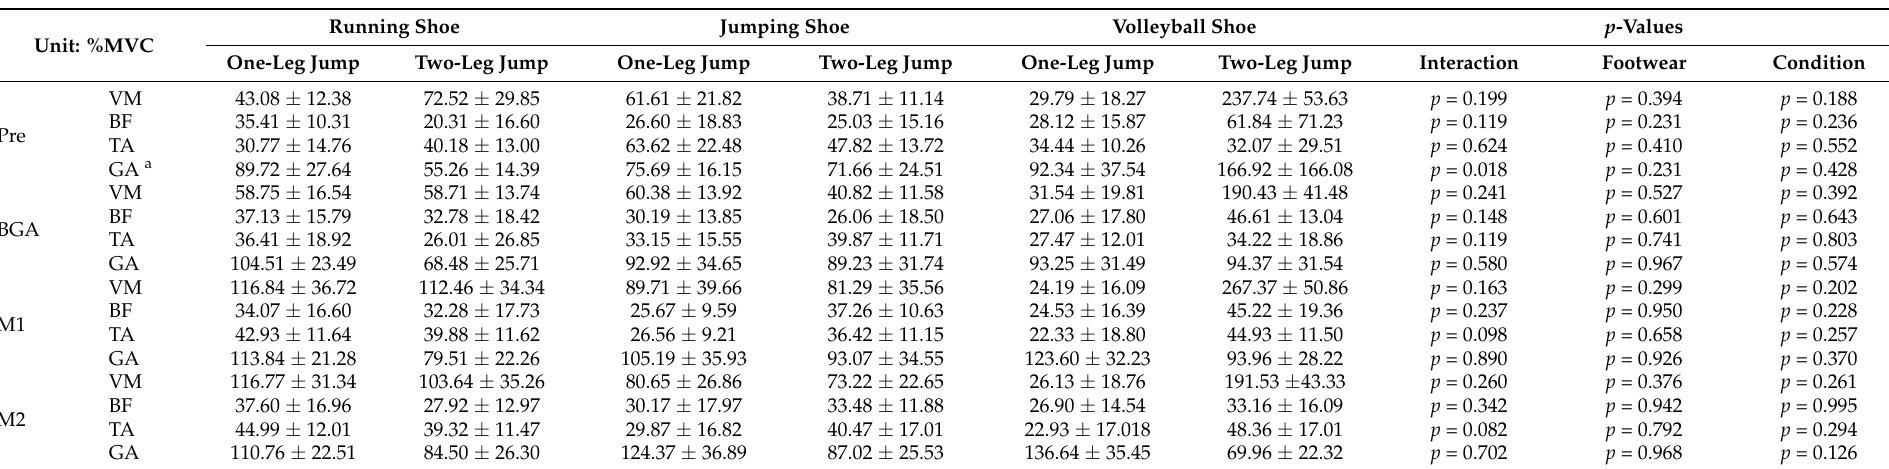
Table 3. The descriptive statistics (Mean ± SD) and statistical result of EMG variables during jump rope